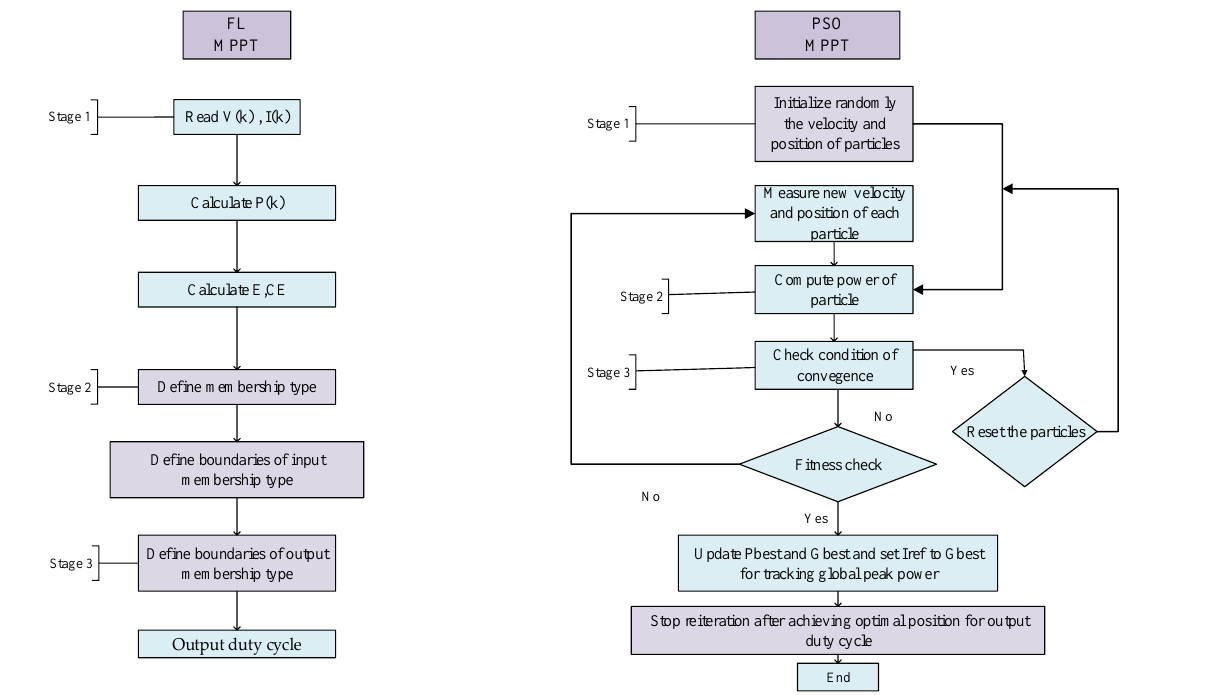
Figure 5. Flow diagram of MPPT strategies for comparative analysis of faults.